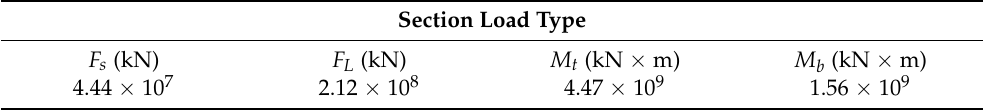
Table 8. Ultimate cross section internal force.